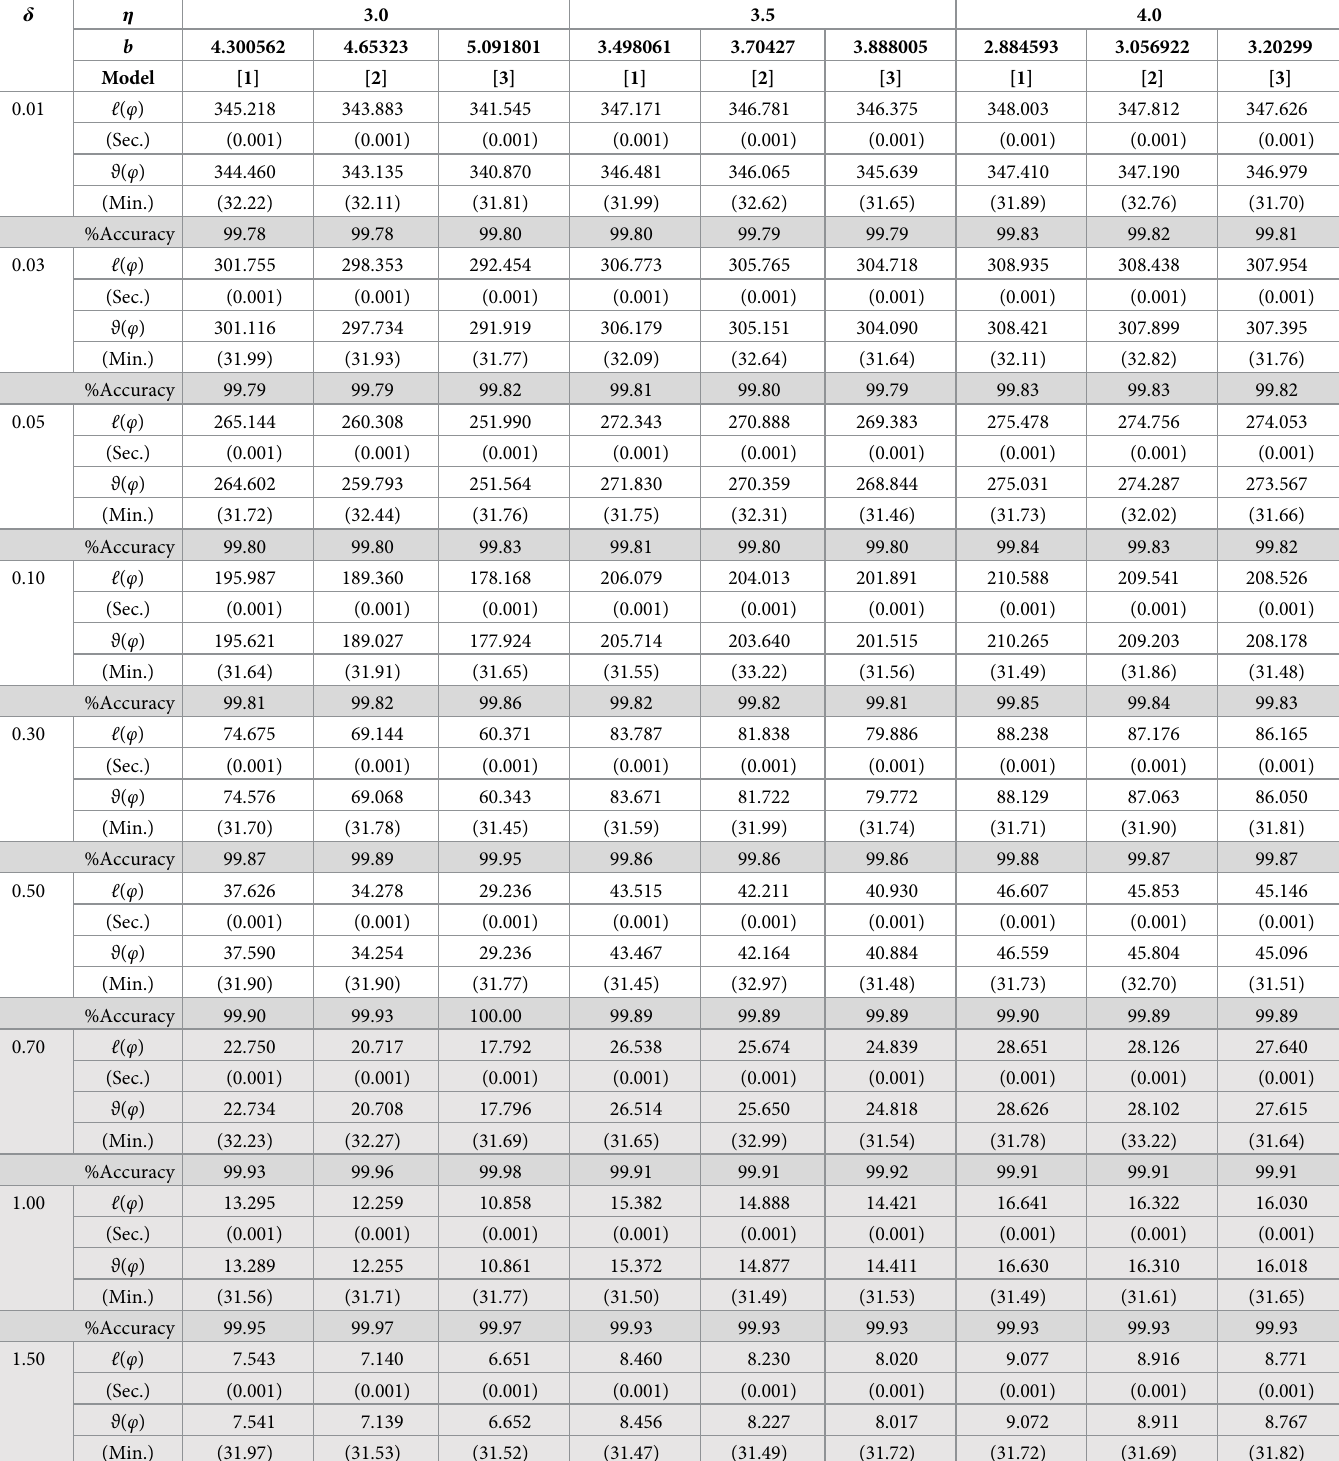
Table 2. Comparison of the ARL 1 values obtained using the analytical and numerical ARL methods for long-memory SARFIMAX( P , D , Q , r ) s processes with expo- nential white noise on a CUSUM control chart for ARL 0 = 370 with F 1 = 0.1, F 2 = 0.2, Θ 1 = 0.1, and ω 1 =